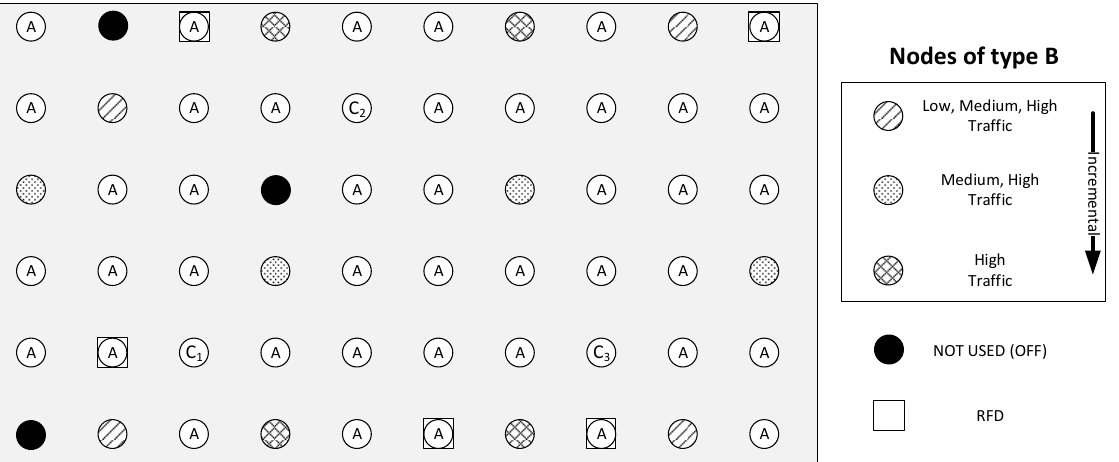
Figure 4. The testbed layout and Roles A, B and C assigned to the nodes of the testbed for the basic topology. Nodes that are not of Role B or of Role C at a certain traffic scale are of Role